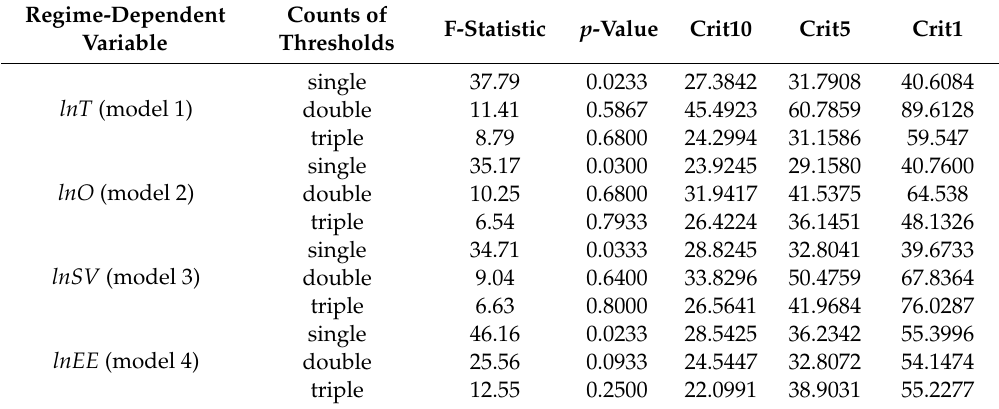
Table 3. Results of the threshold e ff ect test of di ff erent regime-dependent variables under